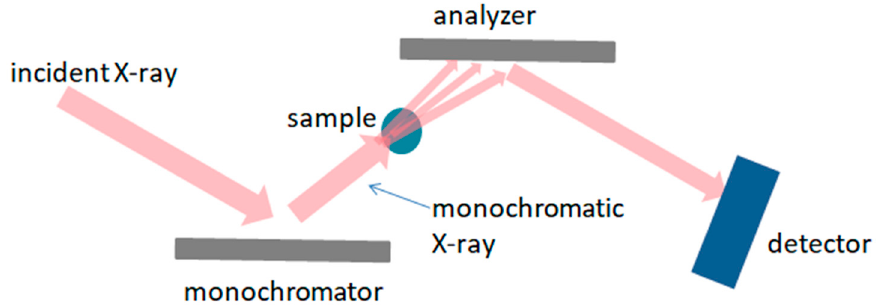
Figure 13. Sketch of diffraction-enhanced imaging (DEI) setup. Two crystals work as monochromator and analyzer.